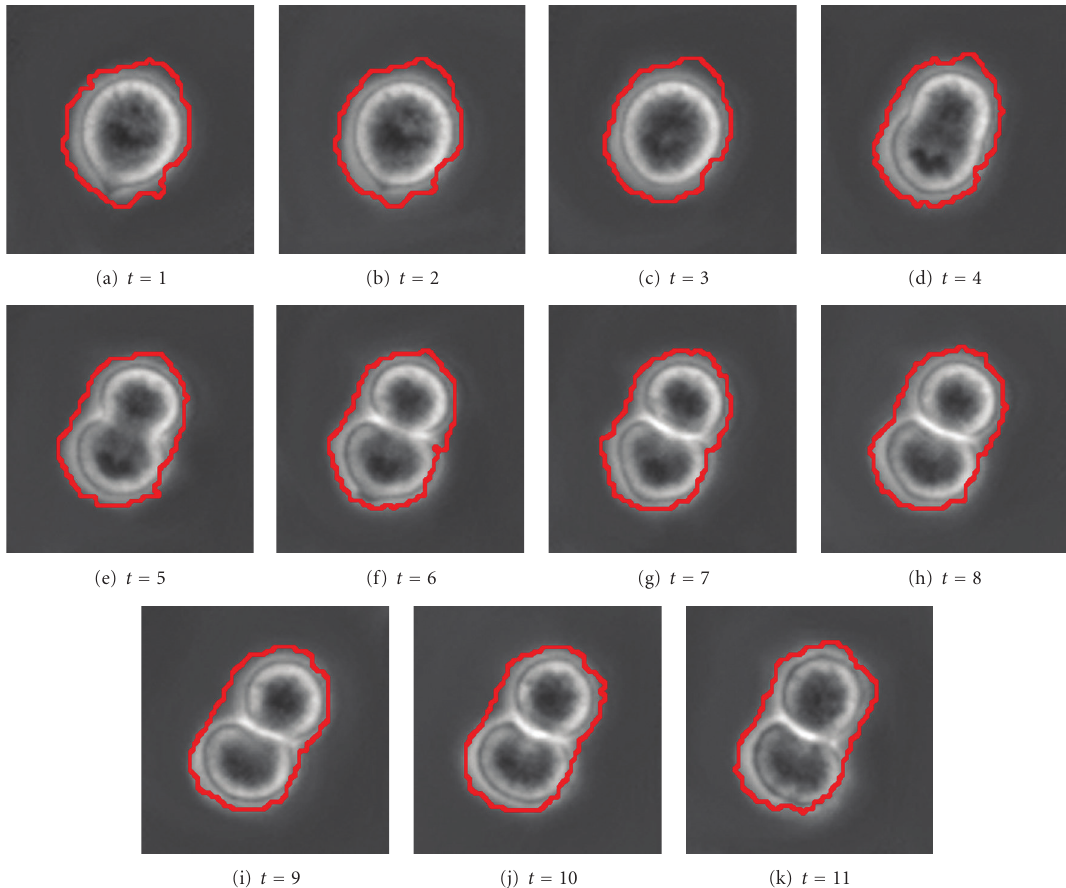
Figure 20: 2 segments found with parameters ( n , α , (cid:7) α , β , θ , γ , d 1 , σ , ρ ) = (60,8,4,200,0 . 025,0 . 15,0 . 15,6,1).